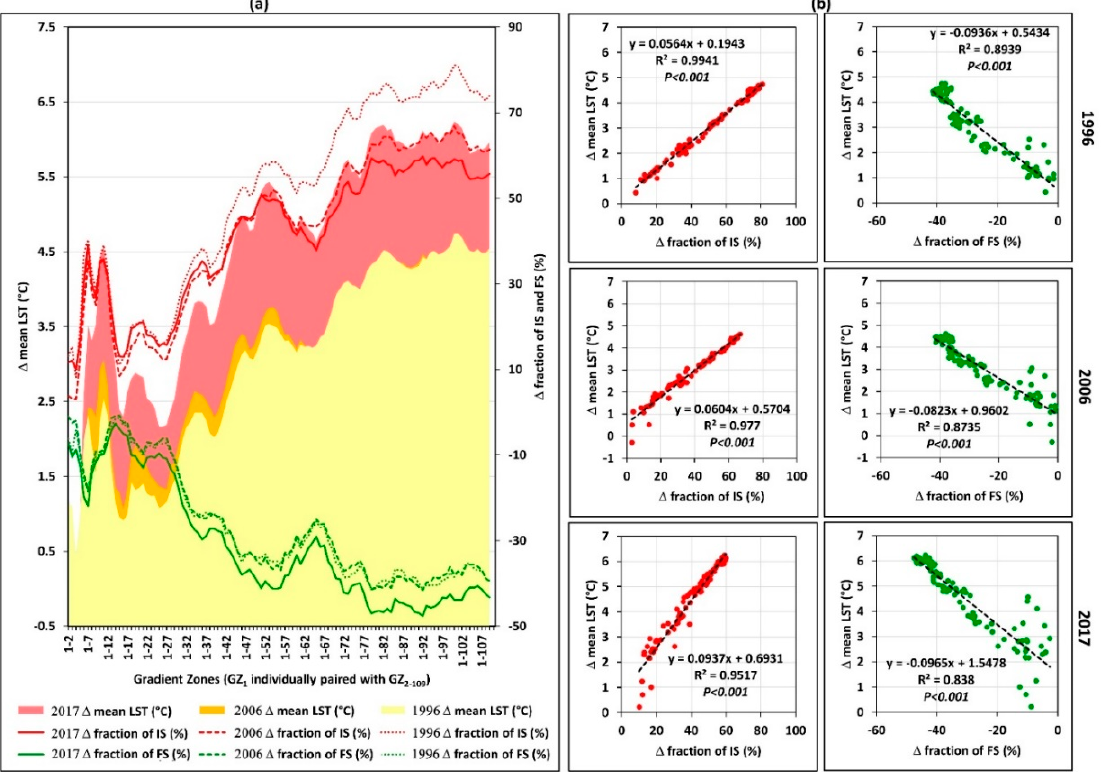
Figure 5. ( a ) Magnitude of SUHII trend and fractional difference of IS and FS along the GZs. ( b ) Scatter plots and statistical relationship between the difference of mean LST and fractional difference of IS and FS along GZs in 1996, 2006, and 2017.